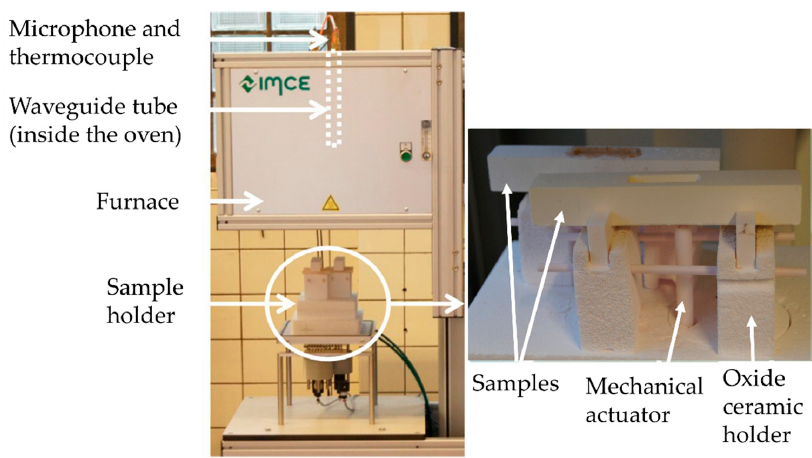
Figure 1. RFDA facility for high temperature investigation. RFDA, Resonant Frequency Damping Analysis [17].